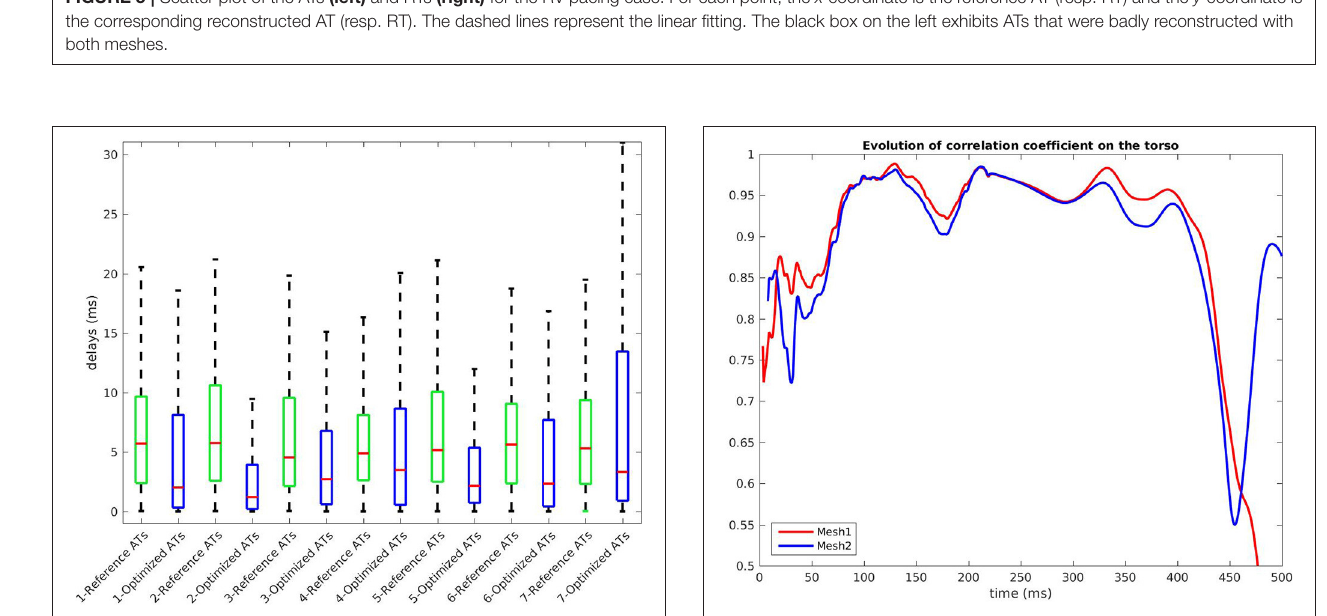
FIGURE 6 | Delays in ATs between endocardium and epicardium for the 7 cases. Box plot represent the median and the first and third quartiles. Whiskers represent the extreme values. Optimized ATs are AT given by the inverse method with Mesh2 . Concerning the reconstructed BSPMs, averaged CC and RMSE are given in Table 3 . Except in case 7, the averaged CC were very similar for both meshes. They kept very close values